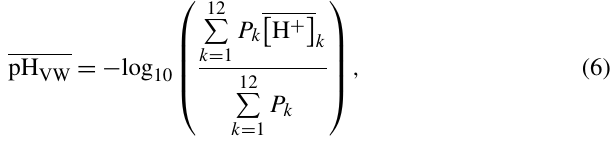
Figure 2. Observed and simulated cloud water pH. Panel (a) shows the GEOS-Chem annual mean cloud water pH below 700hPa for the year 2013 along with cloud water pH observations (filled cir- cles) collected since 1980 (Table A1). See Sect. 2.3 for the proce- dure to compute average pH in the model. White color denotes areas where the topographic elevation is higher than 700hPa. The maxi- mum modeled and observed pH values are 8.2 and 7.3, respectively. Panel (b) shows the observations grouped by region (Table A1), with means ± standard deviations calculated from the ensemble of data sets for the region, and the corresponding GEOS-Chem mean values sampled at the location and month of the measurements. The global mean ± standard deviation pH values computed from the re- gional mean observed and modeled values are inset in panel (b)